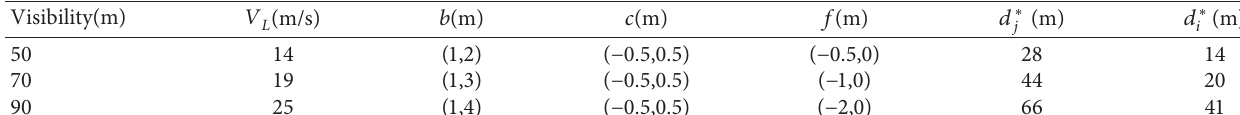
Figure 5: The distance between HDVs and CAVs in different initial headway under the distance of visibility � 70m in dense fog en- vironment on highway. Table 2: The parameters in the numerical